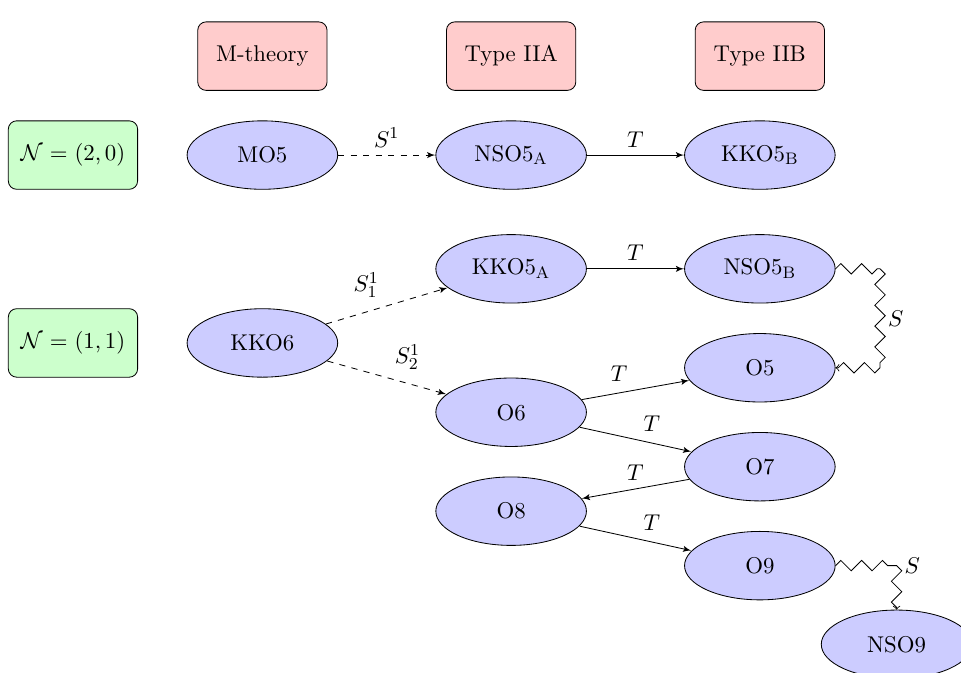
Figure 1 . The various type II/M-theory orientifold compacti(cid:12)cations that give rise to either N = (2 ; 0) or N = (1 ; 1) supergravity theories and the relation among them: S 1 stands for a compacti(cid:12)cation on a circle, whereas T and S refer to T- and S-duality, respectively. The NSO9 plane is a solution of heterotic supergravity and has not been discussed in this